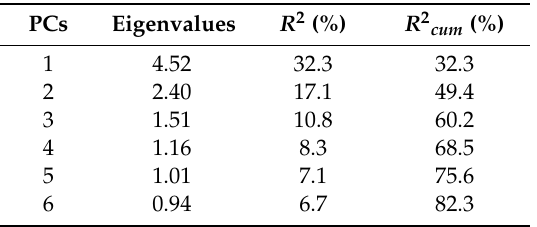
Table 6. Diagnostics of the PCA model on data block [ P 1 , X 2